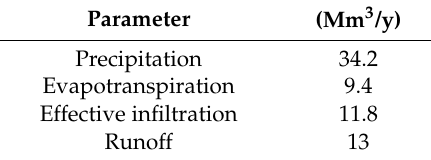
Table 4. Main annual parameters of the hydrologic balance of the Renanchio Basin.